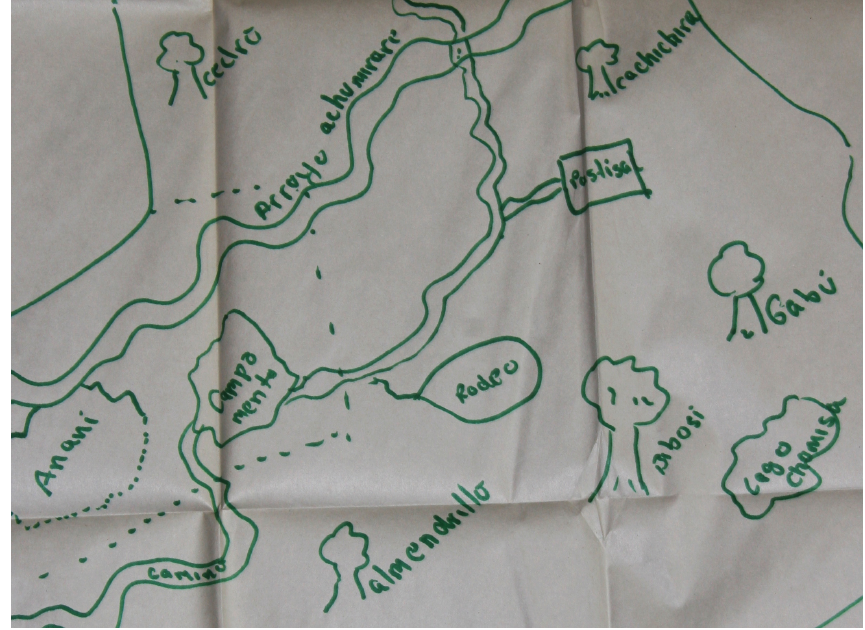
Figure 6. Snippet of a sketch map showing different vegetation